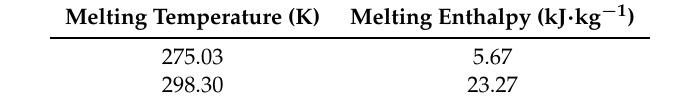
Table 5. Thermophysical characterisation of the studied bio-based phase change materials (PCM).